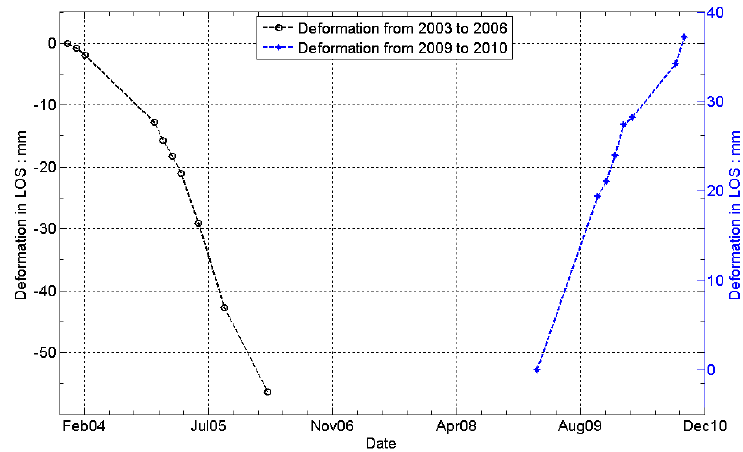
Figure 11. InSAR Line-Of-Sight (LOS) deformation time series for the HeJin area.